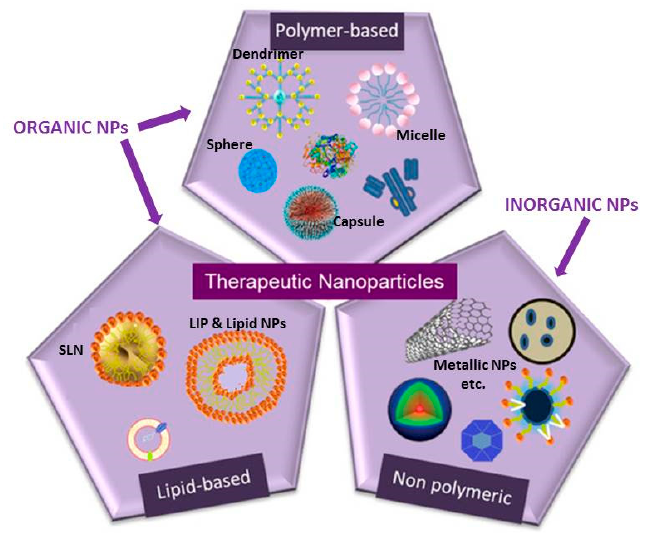
Figure 1. Main types of nanoparticles used as drug carriers (the figure was adapted with permis- sion of [2]. Copyright MDPI,